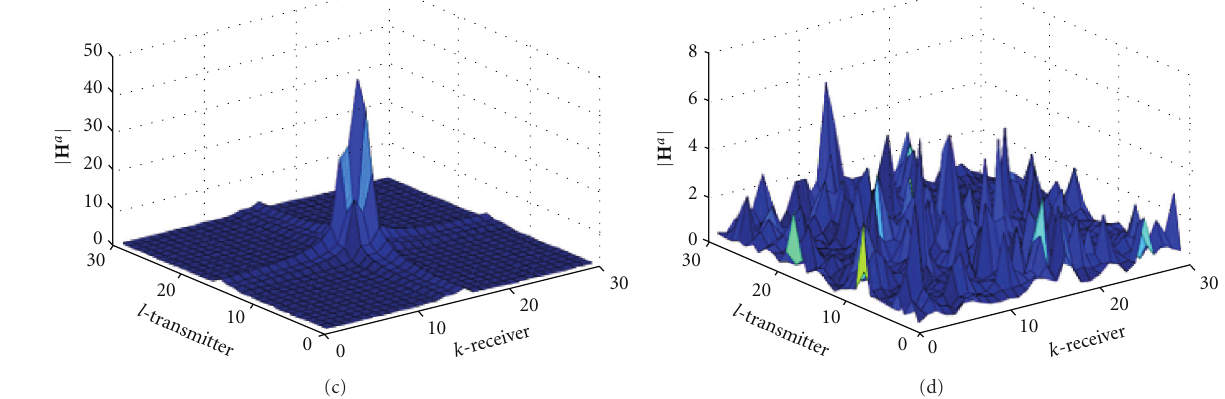
Figure 2: Examples of H a with di ff erent angle spreads at transmitter and